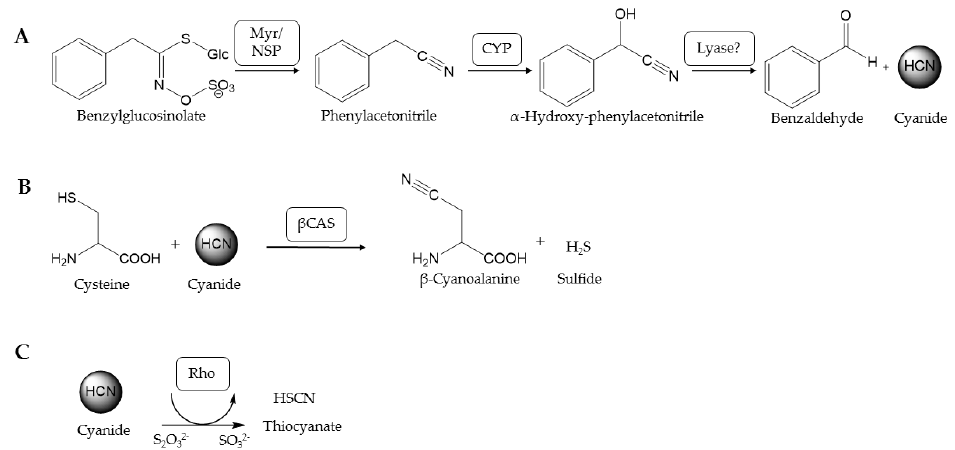
Figure 1. Cyanide formation and detoxification in P. rapae . ( A ) Formation of cyanide upon metabolism of benzylglucosinolate in P. rapae larvae. Aromatic glucosinolates are cleaved by plant